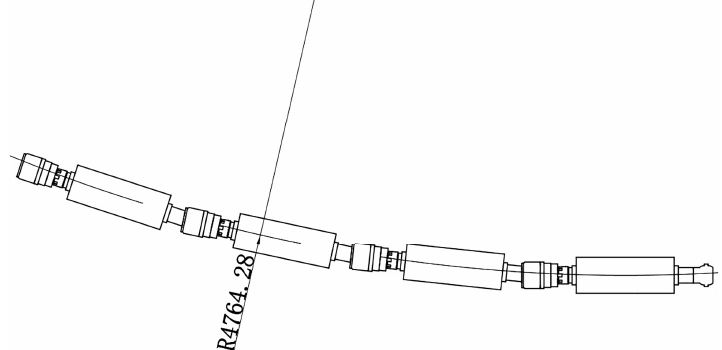
Figure 1. Schematic showing the maximum radius of DFDR-inserted flexible drill string (when the whole string is composed of